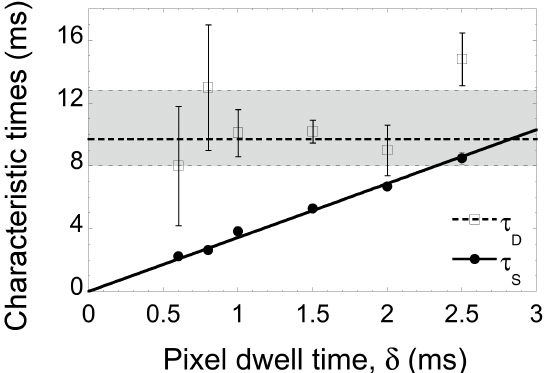
Figure 2. Values of the characteristic diffusion time ( τ ( τ ) obtained for images acquired at different dwell times (mean ± SEM). As expected, S τ increases linearly with δ , and a linear fit of the data (solid line) gives ω S Furthermore, as expected, the diffusion time is constant. The bold dashed line indicates the value of the 50th percentile (median) of τ and 70th percentiles. The median value, τ D = ω 2 / (4 τ ) = 3.1 µ m 2 · s − 1 D 0